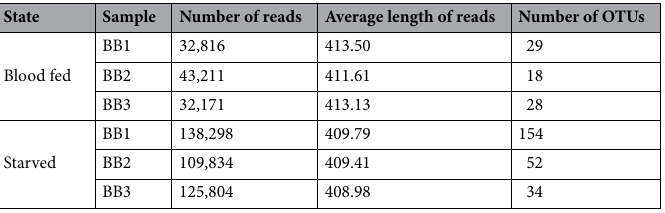
Table 1. General characteristics of sequencing data for each bed bug sample. *BB1-BB3 were